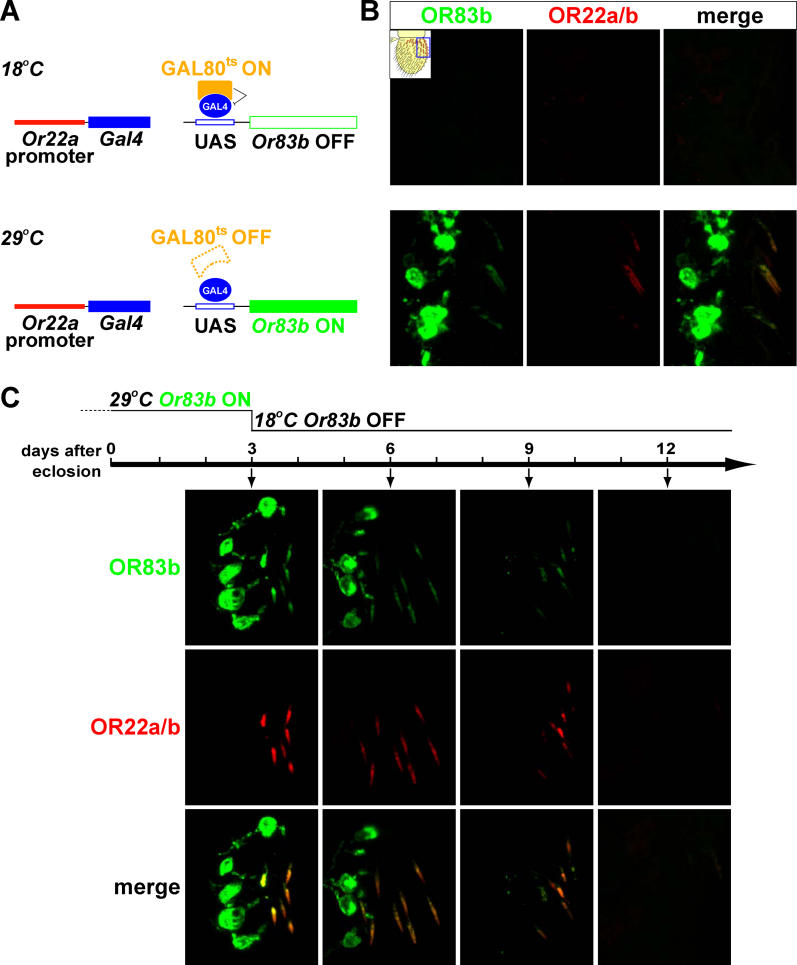
OR83b Is Required to Maintain OR Localization in Adults and Has No Essential Developmental Function(A) Schematic of the TARGET system.(B) Immunostaining for OR83b (green) and OR22a/b (red) in Or83b null-mutant flies rescued using a UAS-Or83b transgene under the control of the TARGET system (Or22a-Gal4,tubP-Gal80ts/tubP-Gal80ts;UAS-Or83b,Or83b1/tubP-Gal80ts,Or83b2). Three copies of the tubP-Gal80ts transgene were used to ensure efficient suppression of GAL4 activity by GAL80 at 18 °C. Flies were cultured and aged as adults for 10 d at 18 °C and then incubated for a further 2 d either at 18 °C (top row) or at 29 °C (bottom row) to induce late expression of Or83b.(C) Immunostaining for OR83b (green) and OR22a/b (red) in flies [genotype as in (B)] that were cultured and aged as adults for 3 d at 29 °C, transferred to 18 °C to switch off Or83b expression, and stained at the time points indicated.